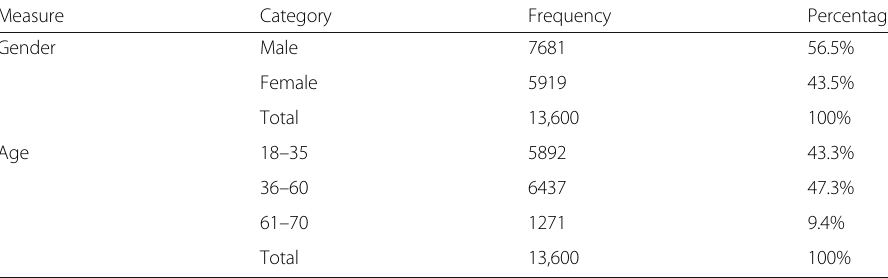
Table 3 Profile of Respondents